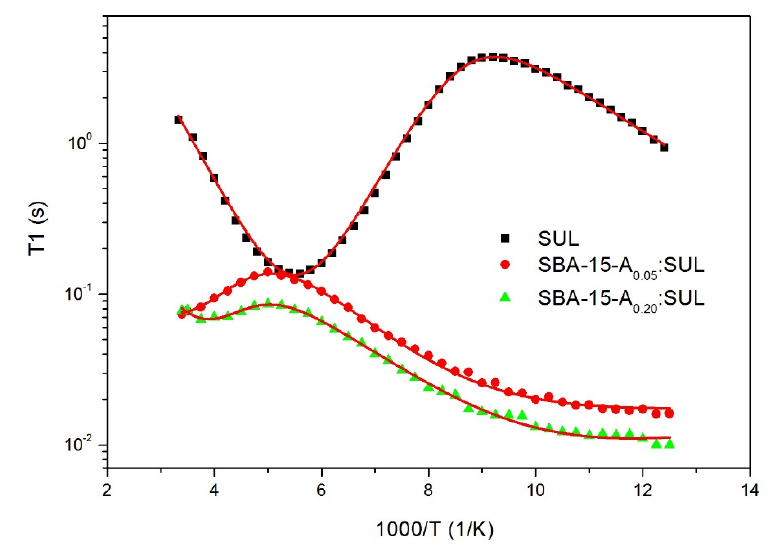
Figure 6. Temperature dependence of the spin ‐ relaxation time T 1 in the laboratory frame for SUL, SBA ‐ 15 ‐ A 0.05 :SUL, and SBA ‐ 15 ‐ A 0.20 :SUL. SBA-15-A 0.05 :SUL, and SBA-15-A 0.20